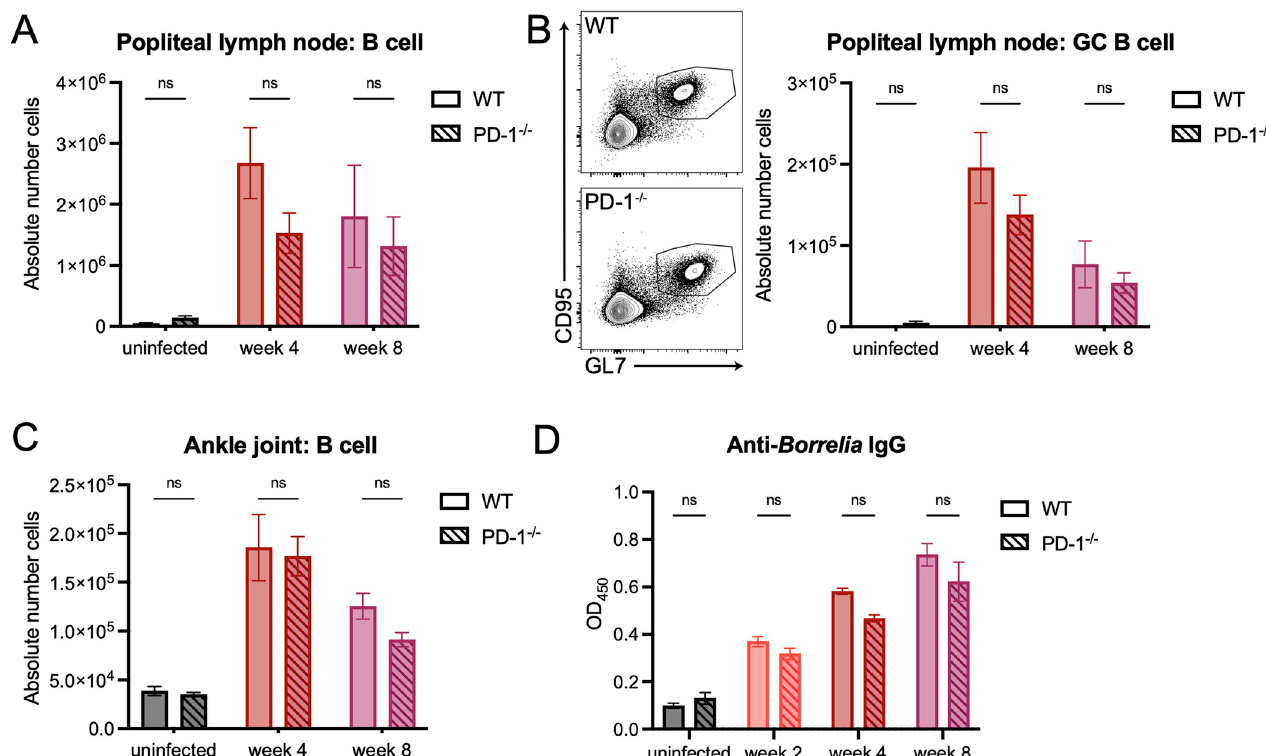
Fig 7. B cell responses to B . burgdorferi remain unchanged in the absence of PD-1. WT and PD-1 -/- mice were inoculated with B . burgdorferi or media alone. Popliteal lymph nodes were isolated and assessed by flow cytometry for total numbers of (A) B cells (live ➔ CD45 + B220 + cells) and (B) germinal center B cells (GL7 + CD95 + B cells). (C) Ankle joints were assessed for total B cells and (D) serum was assessed for anti- Borrelia IgG antibodies through ELISA. Data are pooled from at least two independent experiments with five mice per group and were analyzed using two-way ANOVA with Sidak’s multiple comparisons